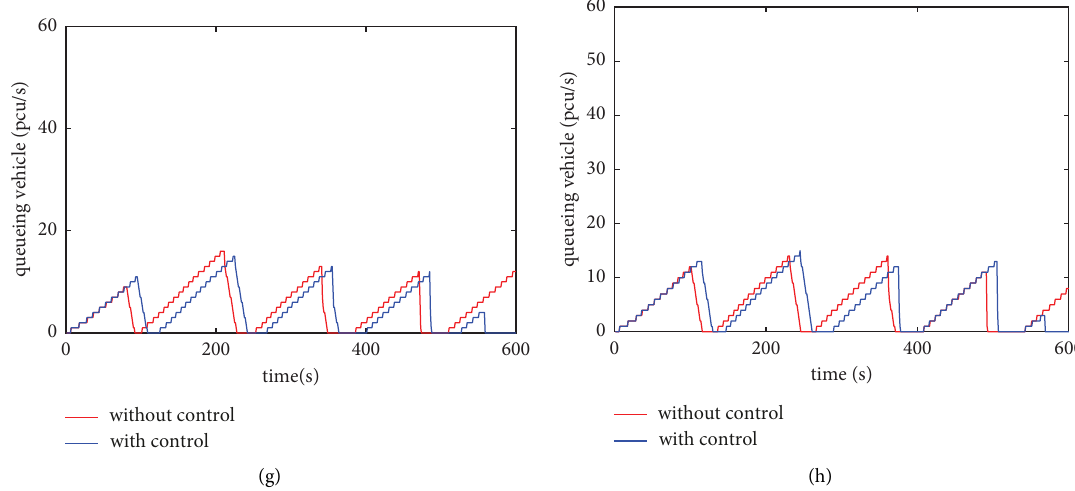
Figure 6: Comparison of queueing vehicle numbers with and without control. (a) Phase one. (b) Phase two. (c) Phase three. (d) Phase four. (e) Phase fve. (f) Phase six. (g) Phase seven. (h) Phase